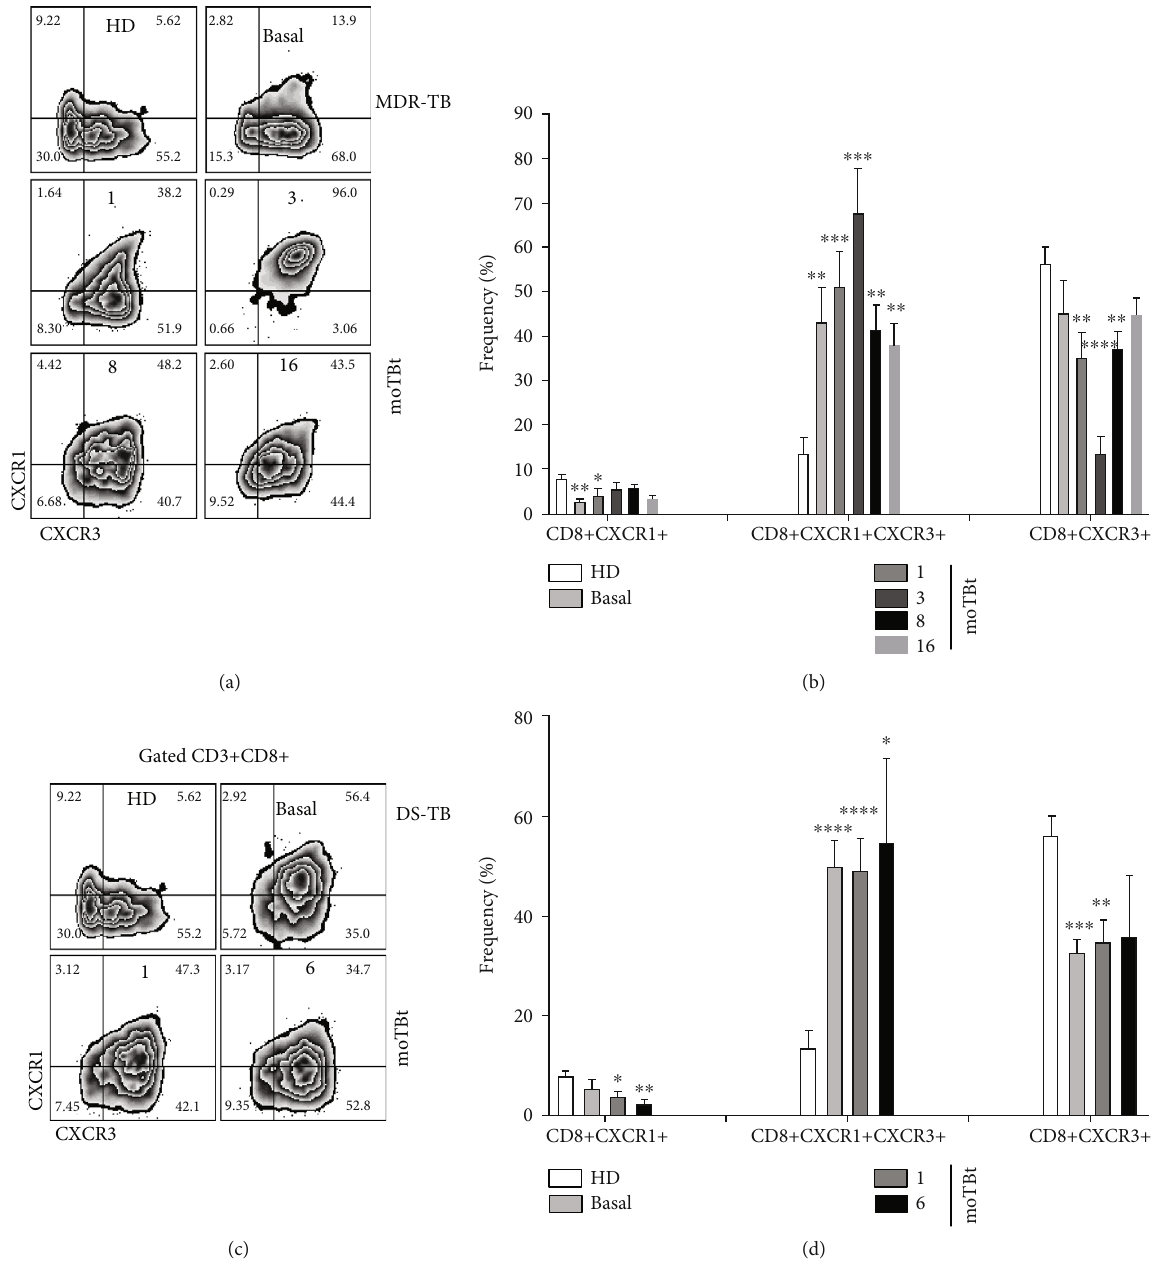
Figure 7: Expression of CXCR1 and CXCR3 in CD8+T cells from MDR-TB and DS-TB patients. Representative zebra plots showing the strategy used to determine the expression of CXCR1 and CXCR3 CD3+CD8+ T cells. Peripheral blood mononuclear cells (PBMCs) from multidrug-resistant (MDR-TB) or drug-sensitive (DS-TB) patients were obtained at di ff erent times before and after anti-TB treatment and used for phenotypical characterization by fl ow cytometry (a and c, respectively). (b) Frequency of CD8+CXCR1+, CD8+CXCR1+CXCR3 +, and CD8+CXCR3+ T cell subpopulations in MDR-TB patients (HD: n = 6 , MDR-TB: basal, 1, and 3 moTBt n = 10 , 8 moTBt n = 8 , and 16 moTBt n = 7 ). (d) Frequency CD8+CXCR1+, CD8+CXCR1+CXCR3+, and CD8+CXCR3+ T cell subpopulations in DS-TB patients (HD: n = 6 , DS-TB: basal and 1 moTBt n = 10 , and 6 moTBt n = 8 ). Bar graphs show means ± standard errorof the mean ð SEM Þ . Di ff erences between patient groups and HD at each time point were analyzed using multiple Student ’ s t -test corrected for multiple comparisons using the Sidak – Bonferroni method. ∗ p < 0 : 05 , ∗∗ p < 0 : 01 , ∗∗∗ p < 0 : 001 , and ∗∗∗∗ p < 0 : 0001 . moTBt: months of antituberculosis